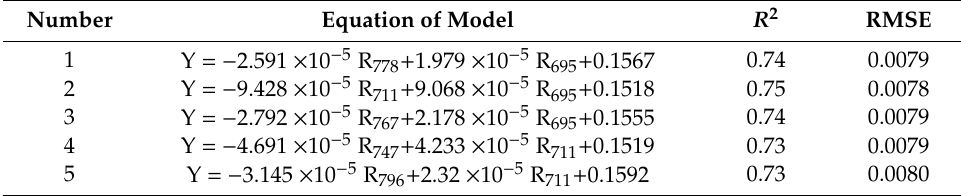
Table 5. Multivariate linear inversion model and accuracy.